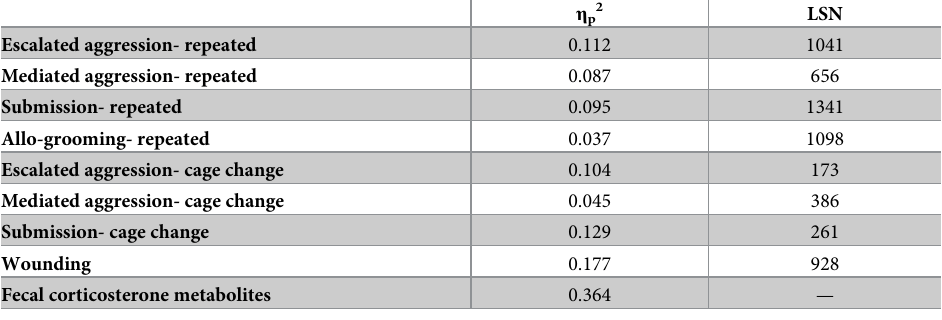
Table 4. Effect size ( η M p2 ) and least significant number (LSN) needed for a significant effect of treatment on each measure analyzed using mixed models.